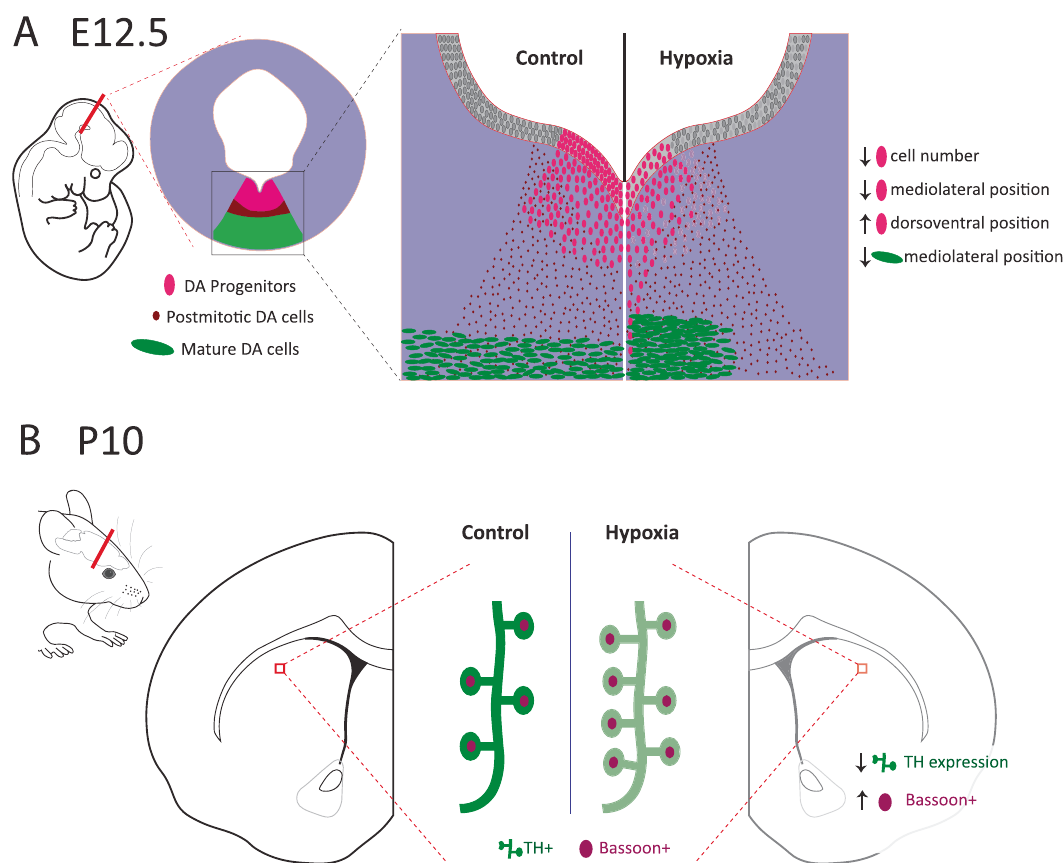
Fig. 4 Summary fi gure of the effects of prenatal hypoxia on dopamine neuron ontogeny. A Prenatal hypoxia induces early changes progenitor cell number, progenitor lateral and ventral positioning and a reduction in lateral positioning of more mature TH + neurons. B This correlates with a postnatal reduction in the intensity of TH expression and a potentially compensatory increase in presynaptic release sites in TH-positive terminals. Importantly these fi ndings are in the dorsal striatum not the nucleus accumbens consistent with the anatomical loci of presynaptic DA abnormalities reported in